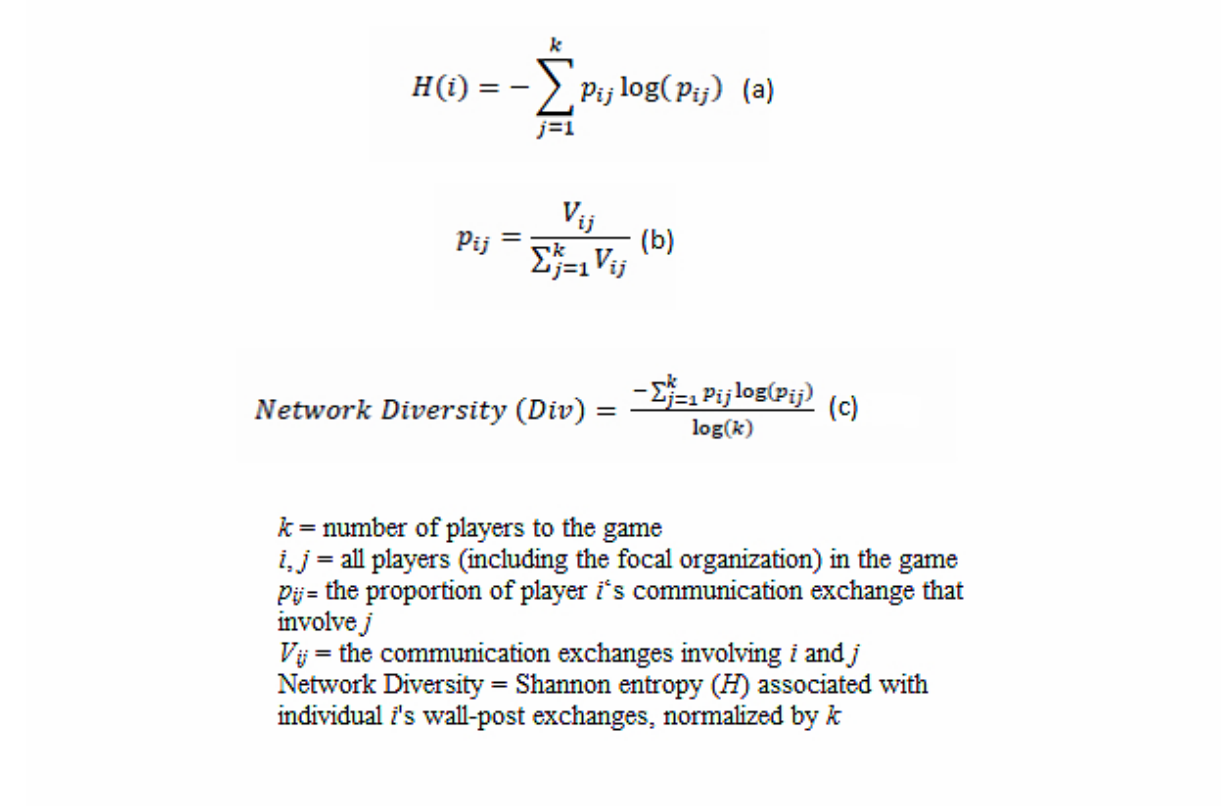
Figure 4. (a) Represents the Shannon’s diversity index equation. (b) Represents the communication exchange between the players. (c) Shows network diversity as it relates to Shannon's entropy and player's wall